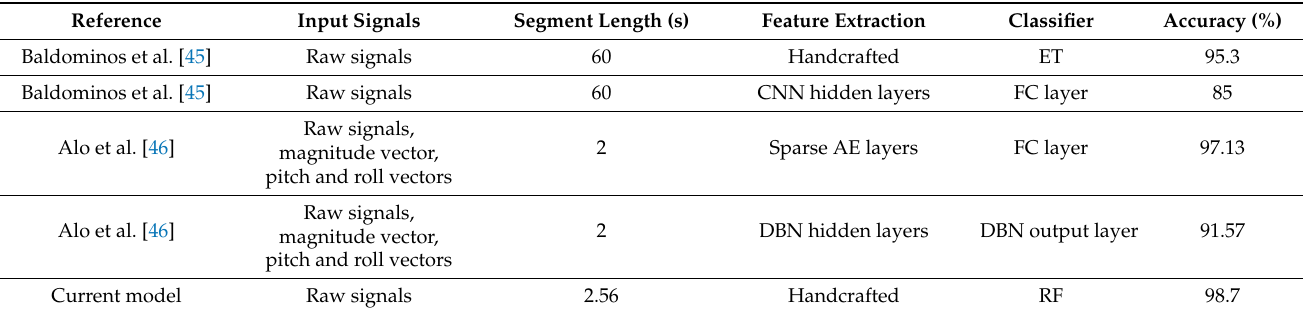
Table 5. Recognition rates of each activity for different models under subject-dependent validation criteria. ET: ensemble of randomized trees, FC: fully connected layer, AE: autoencoders, and DBN: deep belief networks.